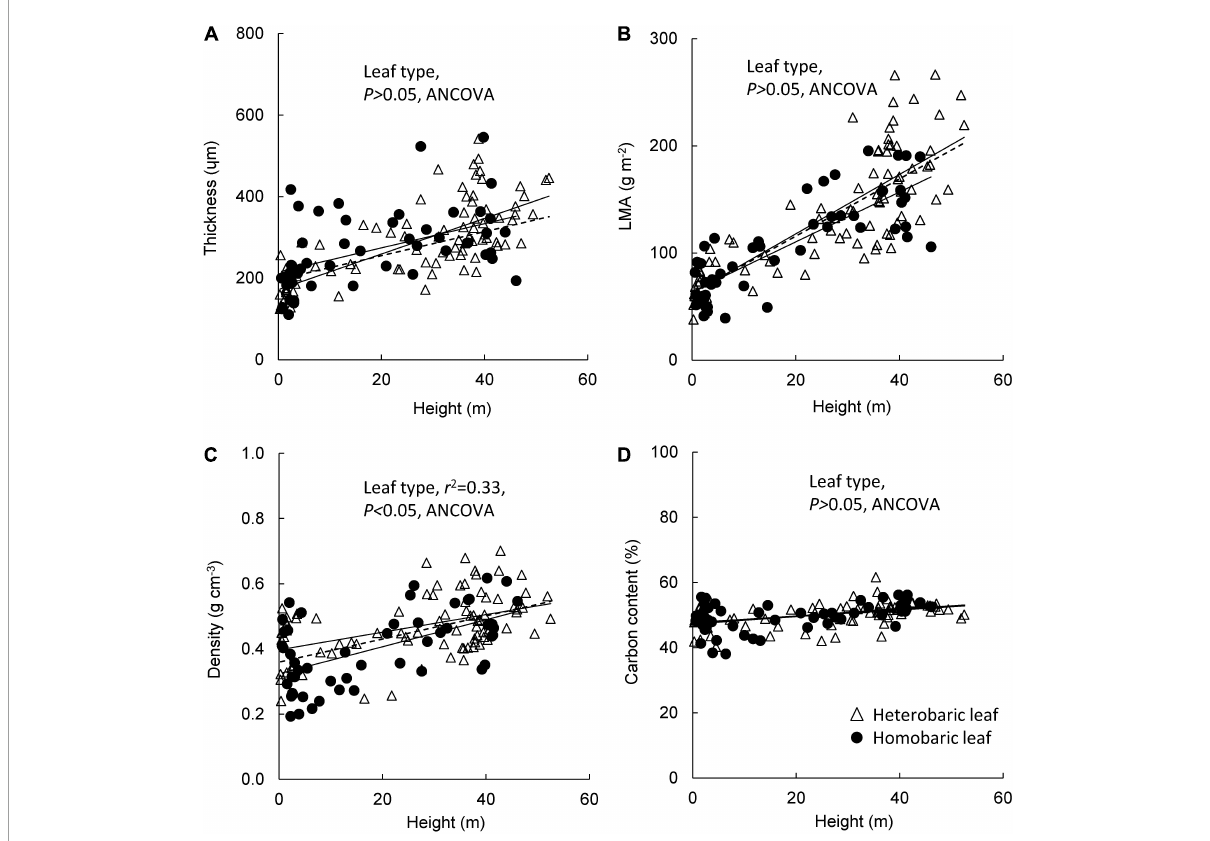
FIGURE3 Changes in leaf traits with tree height for heterobaric and homobaric leaves: height in relation to leaf blade thickness (A) , LMA (B) , leaf density (C) , and carbon content (D) . Regression lines are as follows: (A) heterobaric leaf, r 2 = 0.53, P < 0.0001; homobaric leaf, r 2 = 0.24, P < 0.001; (B) heterobaric leaf, r 2 = 0.65, P < 0.0001; homobaric leaf, r 2 = 0.67, P < 0.0001; (C) heterobaric leaf, r 2 = 0.21, P < 0.0001; homobaric leaf, r 2 = 0.21, P < 0.0001; (D) heterobaric leaf, r 2 = 0.20, P < 0.001; homobaric leaf, r 2 = 0.19, P < 0.001. Details of the results of ANCOVA appear in Appendix 7. Dotted line means regression line for pooled data for both leaf